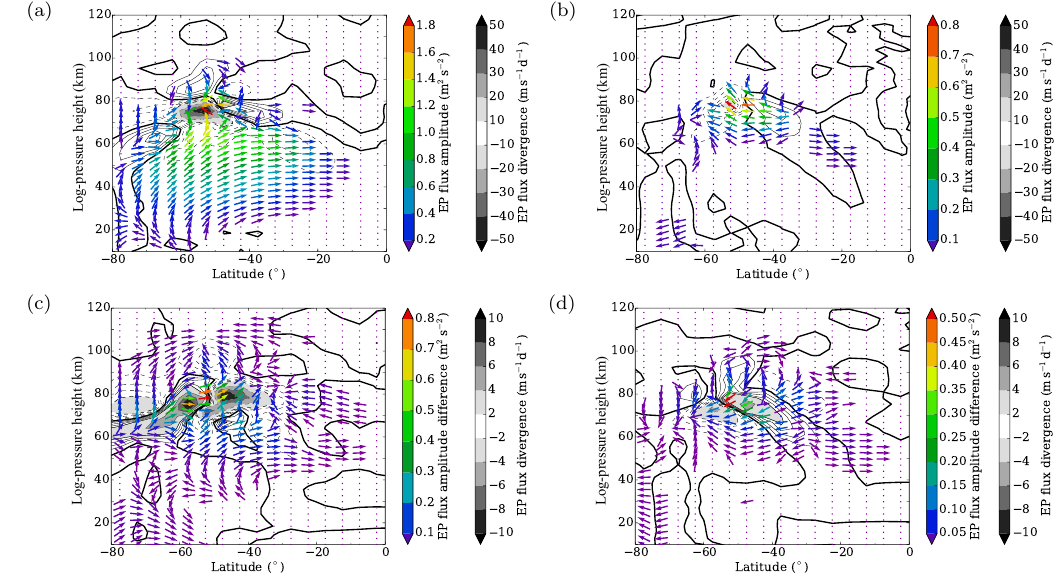
Figure 4. Run1 EP flux vectors for SPW1 (a) and SPW2 (b) . Normalized arrows represent the direction of EP flux. EP flux components are scaled by ρ 0 a cos φ , and their amplitude (in m 2 s − 2 ) is given by color coding. Only points where the amplitude is less than 1% of the maximum amplitude in the field are shown. EP flux divergence, also scaled by ρ 0 a cos φ , is added as solid (dashed) isolines for positive (neg- ative) values. Contour intervals are 2ms − 1 d − 1 between − 10 and 10ms − 1 d − 1 , and otherwise 10ms − 1 d − 1 starting from ± 10ms − 1 d − 1 (also indicated in gray). Run2–Run1 differences are shown in (c) for SPW1 and (d) for SPW2. Here, isolines have intervals of 0 . 5ms − 1 d − 1 between − 2 and 2ms − 1 d − 1 and otherwise 2ms − 1 d − 1 starting from ± 2ms − 1 d − 1 (also indicated in gray).